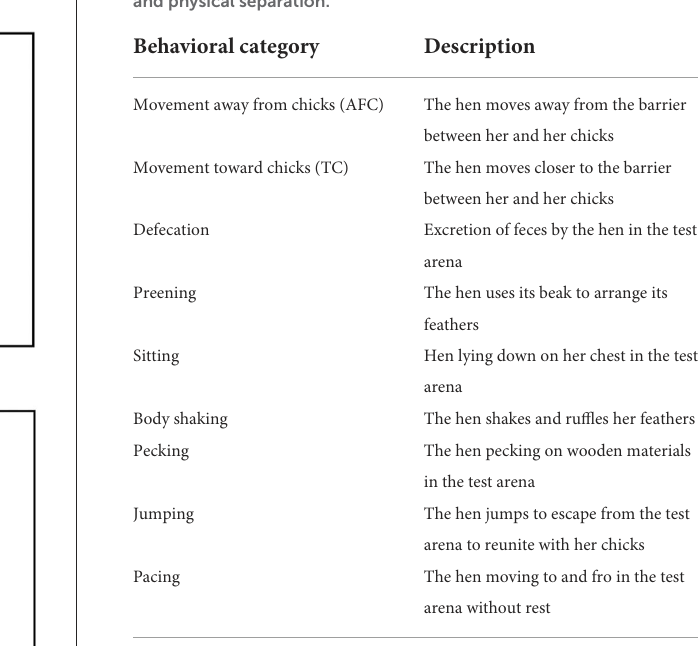
TABLE 1 Ethogram of mother hen behavior monitored during visual and physical